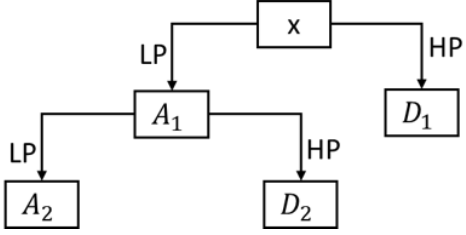
Figure 2. Multi-resolution analysis, the x is the original time series, the A 1 , A 2 present the approximation components, the D 1 , D 2 , are the detailed components, the HP is the high pass filter and LP is the Low pass filter.